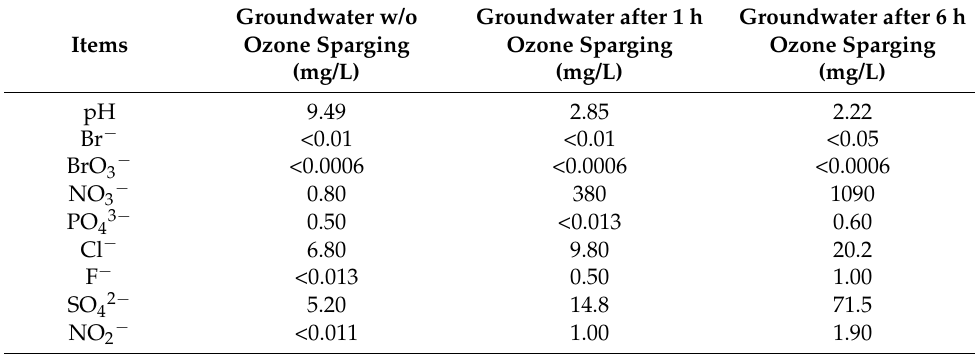
Table 2. Anion concentration before and after ozone sparging in the groundwater.